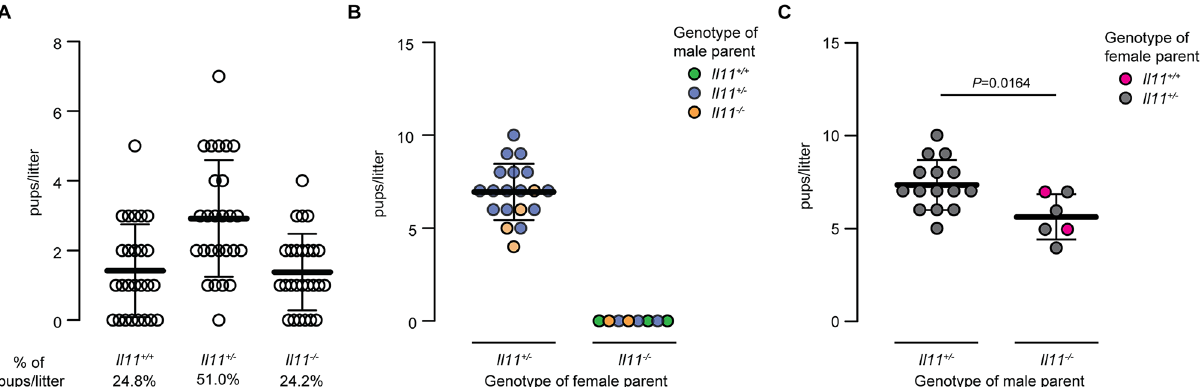
Figure 2. Il11 knockout female mice are infertile. ( A ) Genotype distribution of pups per litter in heterozygous breeding ( Il11 + /− X Il11 + /− ; n = 26 litters). ( B ) Litter size based on parents’ genotype. ( C ) Litter size based on the breeding of heterozygous Il11 + /− or homozygous Il11 −/− male mice with wild-type or heterozygous Il11 + /− female mice. Data shown as mean ± SD. P value was determined by Student’s t